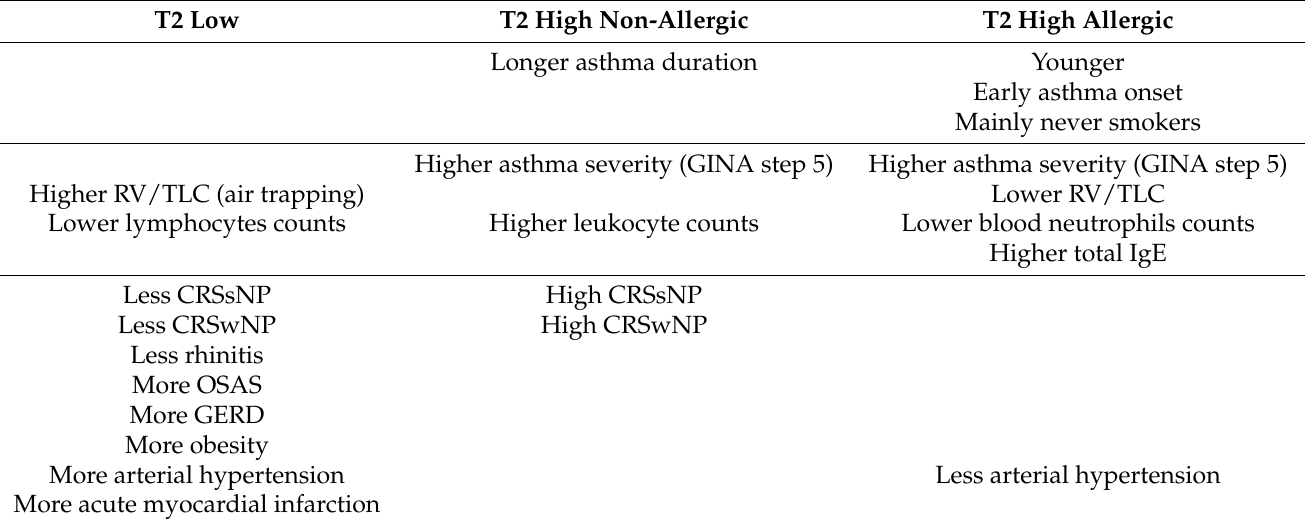
Table 6. Summary of main phenotype